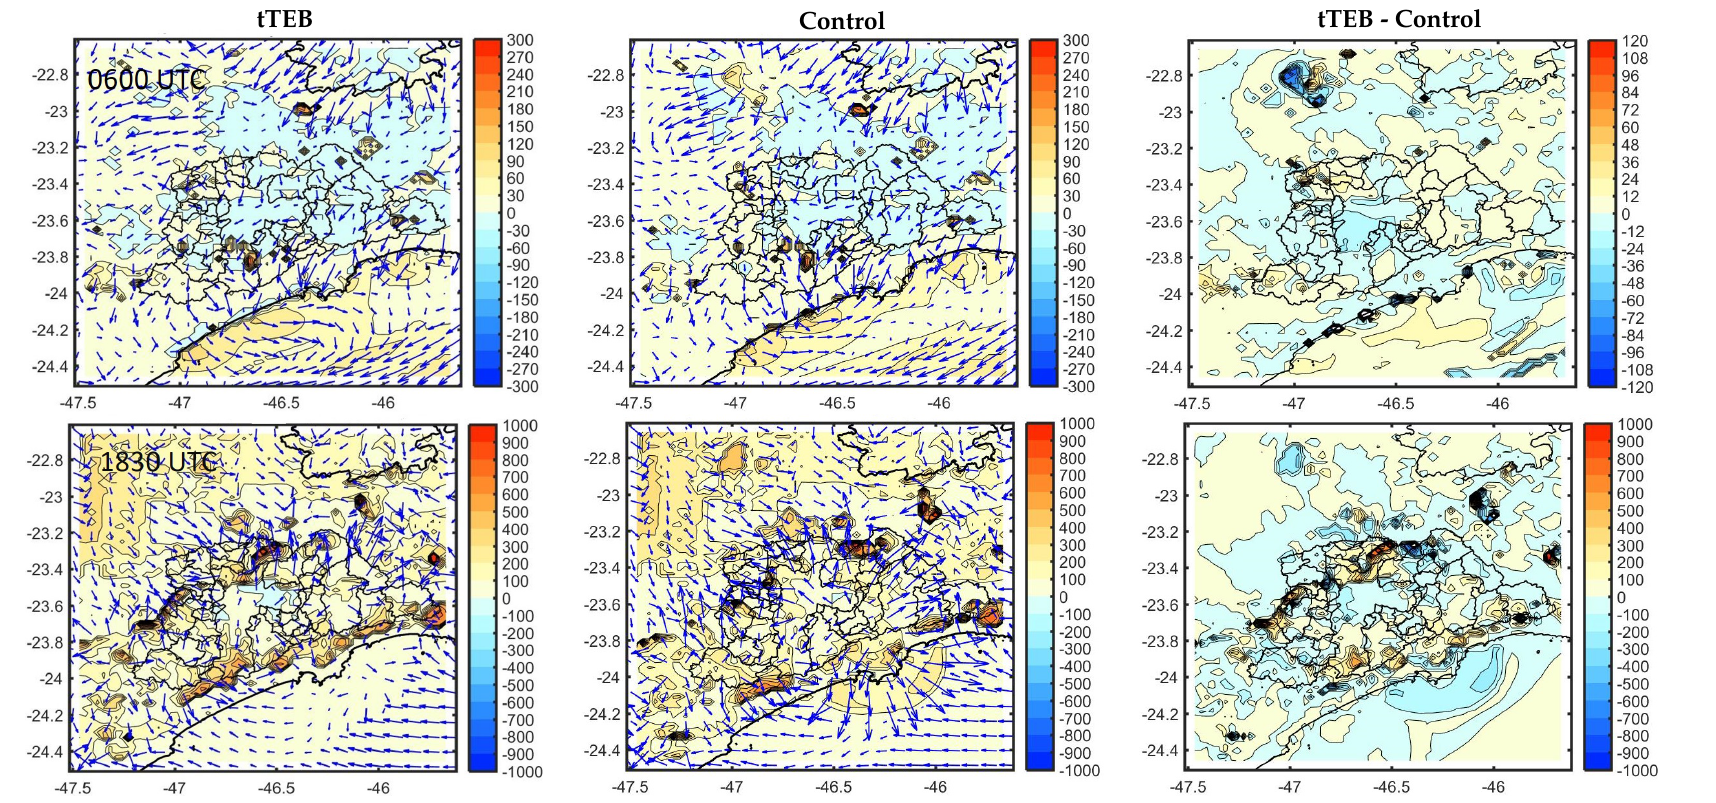
Figure 14. Horizontal pattern of latent heat flux (W m − 2 ) at the surface for 12 January 2015 at 06 UTC (03 LT) (first row) and 1830 UTC (1530 LT) (second row). The figure shows the results of the tTEB experiment (first column), control experiment (second column) and the differences between both experiments (third